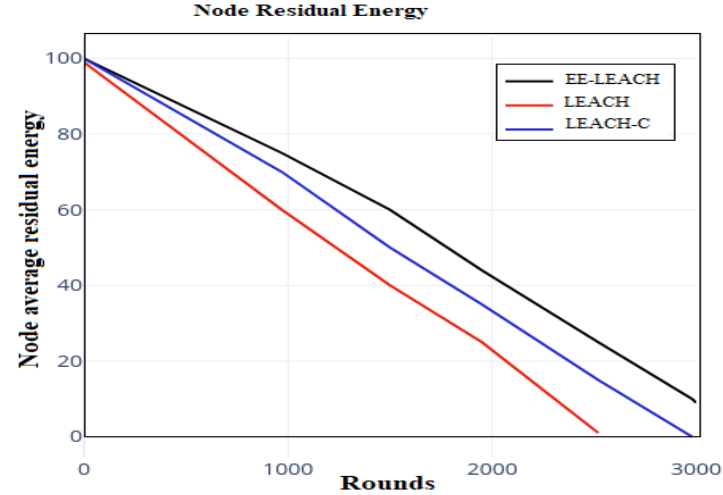
Figure 9. Residual energy vs. rounds.